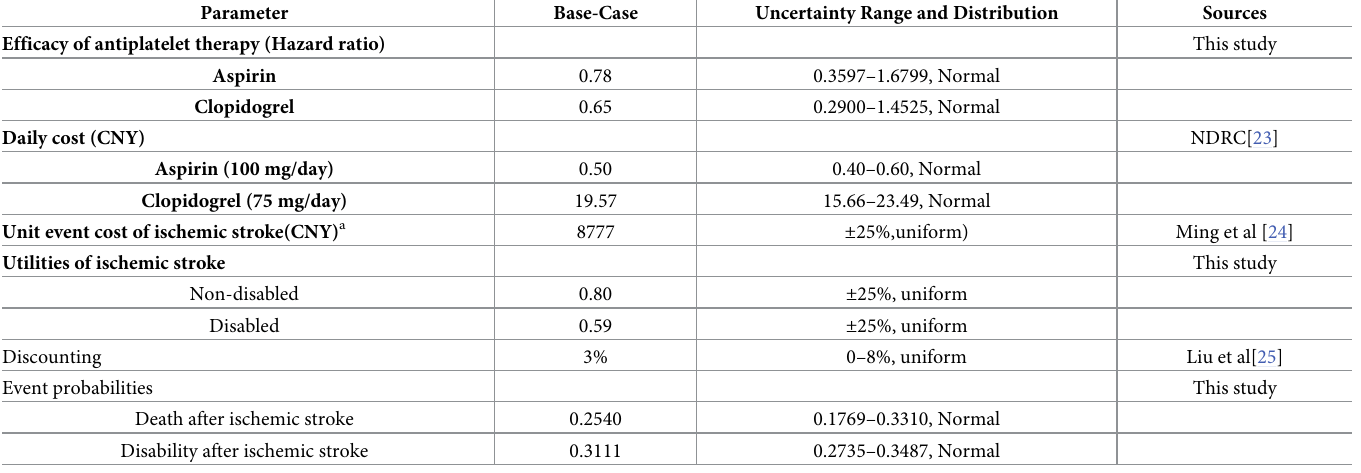
Table 1. Key parameters used in the Markov model. Parameter